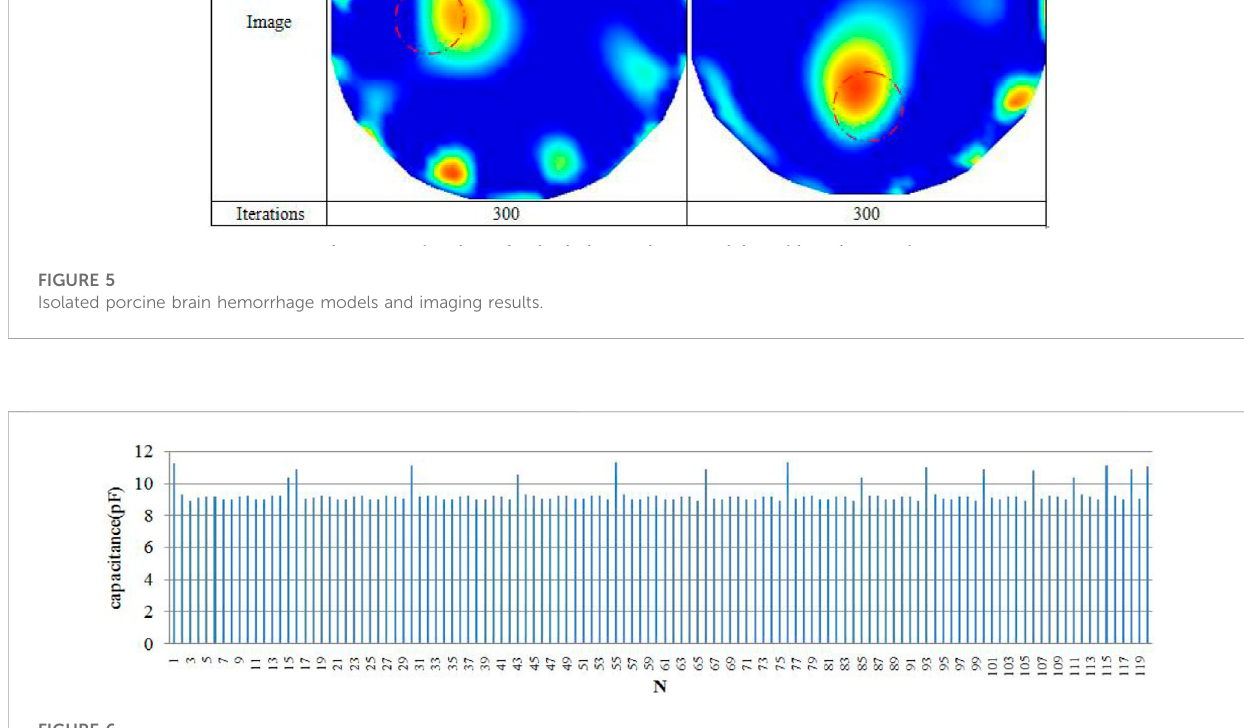
FIGURE 6 Capacitance measurements of 120 independent electrode pairs under an empty fi